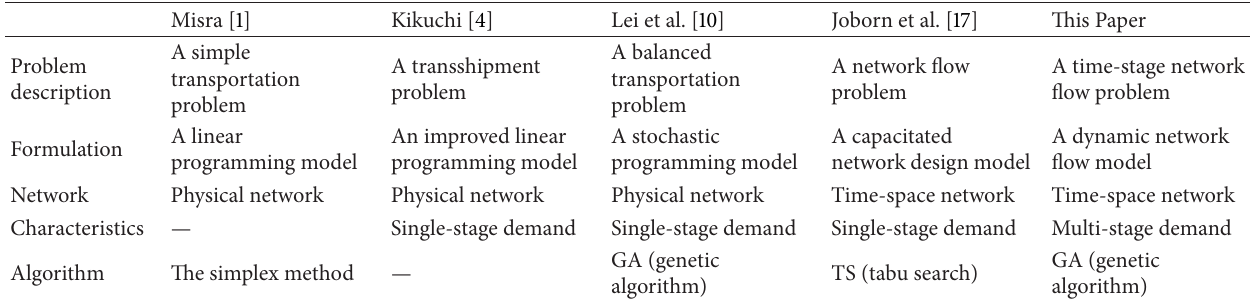
Table 1: The detailed features of different